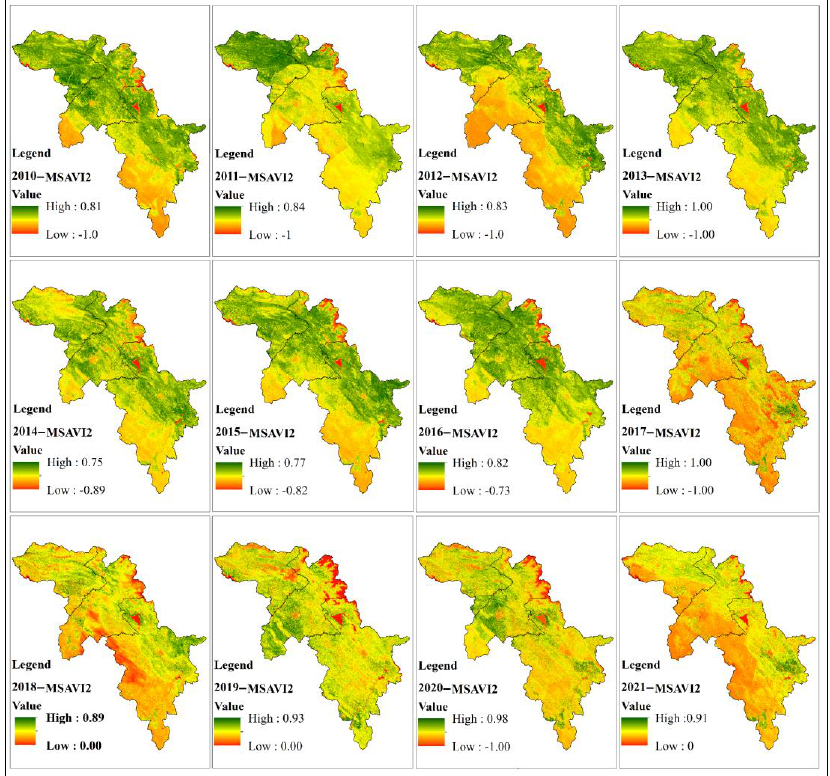
Figure 4. Spatial variation of the MSAVI2 − based vegetation from 2010 to 2021.